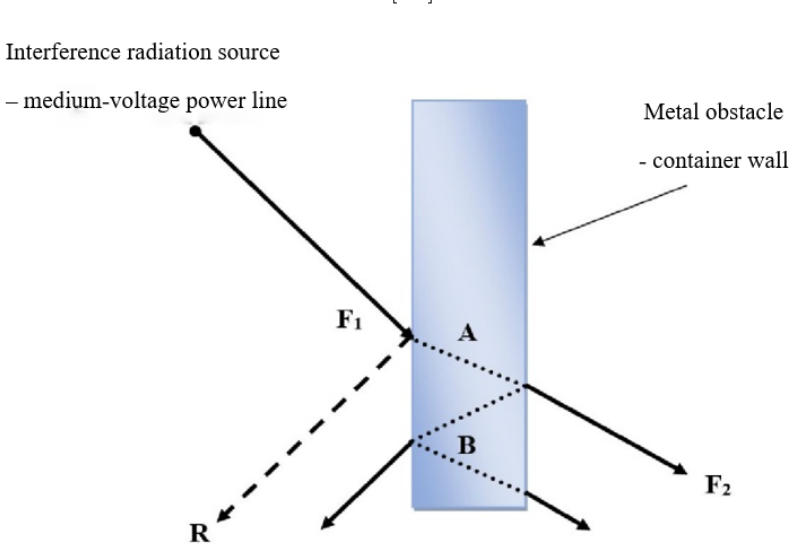
Figure 17. Principle of shielding an electromagnetic wave generated by an MV power line through a metal obstacle constituting the